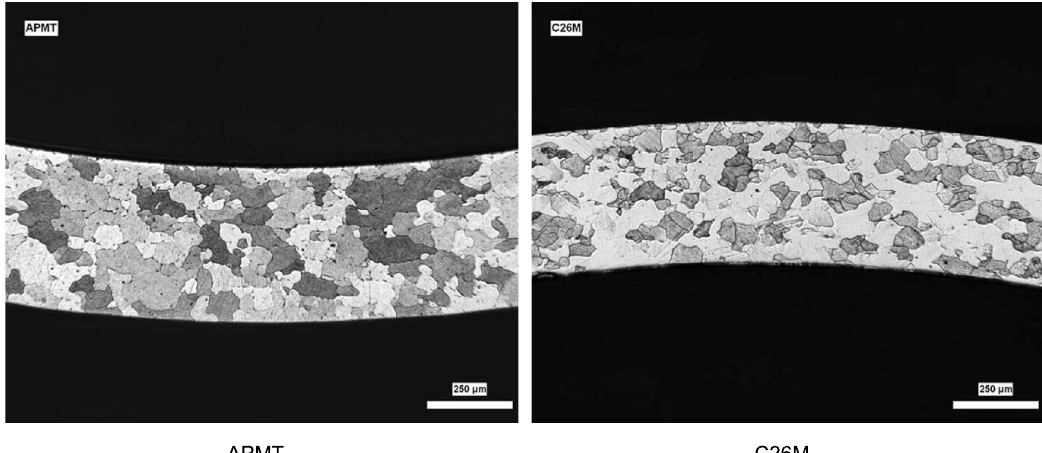
Fig. 6. Thin walled tubes of APMT and C26M fabricated using industrial practices. APMT is Fe + 21Cr+ 5Al+ 3Mo and C26M is Fe +12Cr +6Al